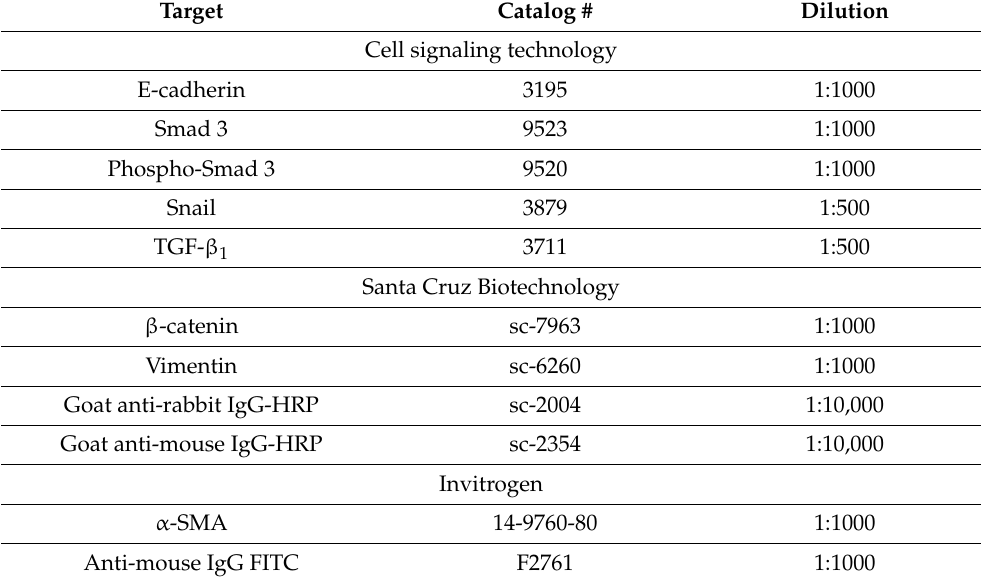
Table 1. List of